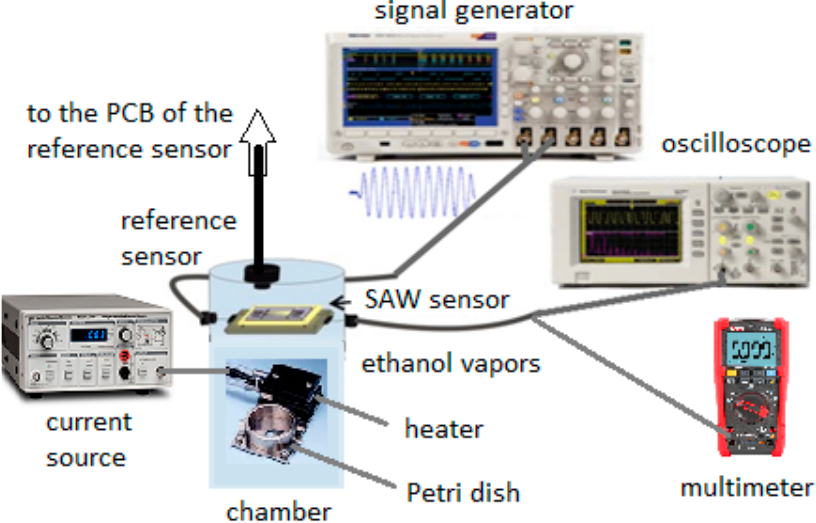
Figure 3. Measurement setup for the functionality testing of the SAW devices with car- nanocoatings and response measurement during ethanol byne-enriched nanocoatings and response measurement during ethanol exposure.